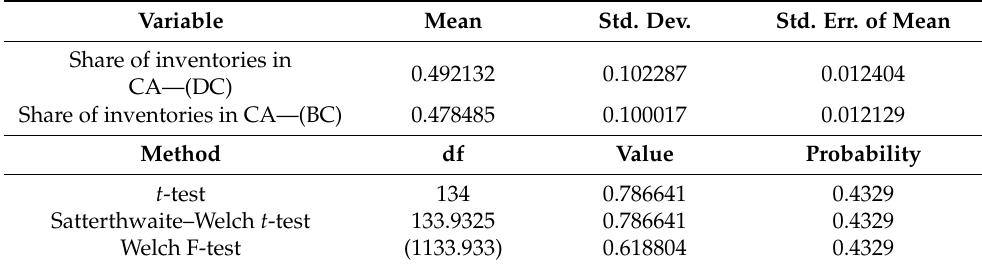
Table 13. The result of the share of inventories in current assets. Variable Mean Std. Dev. Std. Err. of Mean